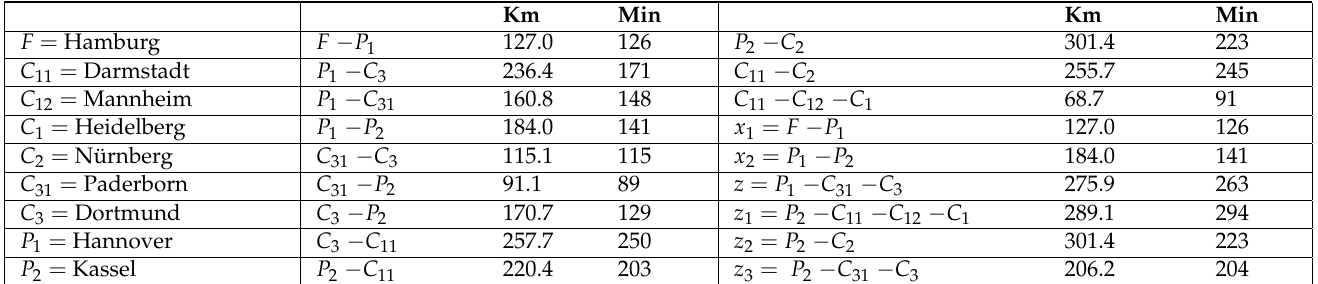
Table 1. Case locations with essential distances (in km) and driving times (in